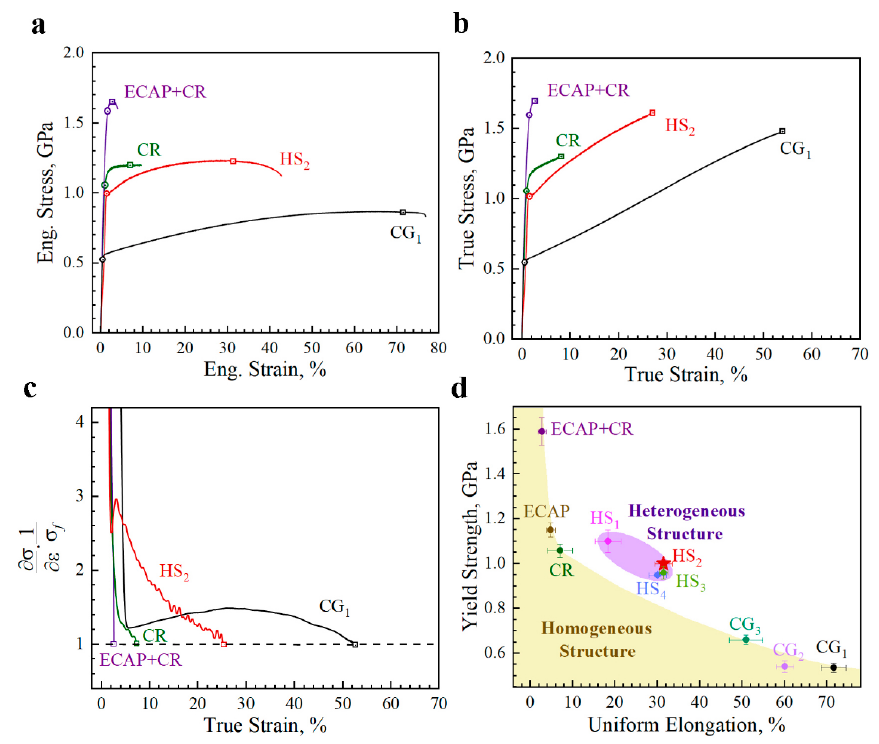
Figure 4. The tensile properties. ( a ) Tensile engineering stress–strain curves for typical microstructures. ( b ) Tensile true stress–strain curves for typical microstructures. ( c ) The curves of normalized hardening rate as a function of true strain for typical microstructures. ( d ) The YS as a function of UE for all tested samples.